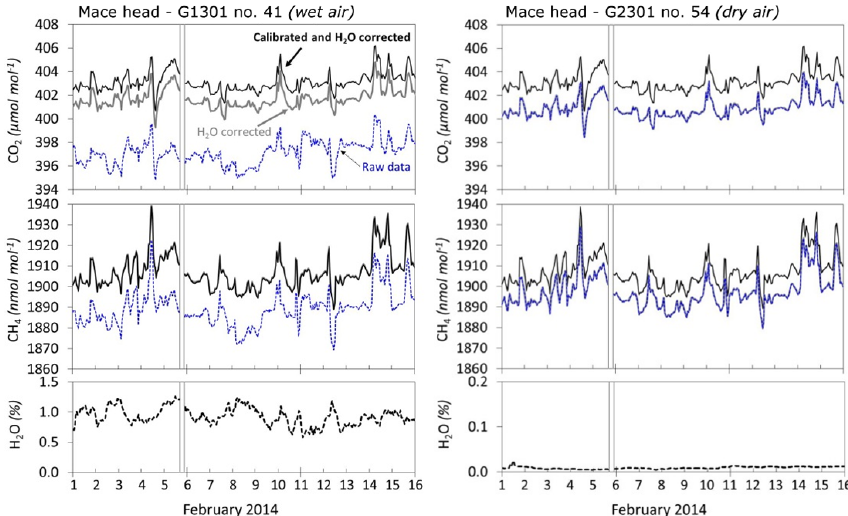
Figure 5. CO 2 (above), CH 4 (middle) and H 2 O (below) mole fractions observed at Mace Head in February 2014 with two CRDS analyzers. Left: analyzer Picarro model G1301 (no. 41) measuring wet air. Right: analyzer Picarro model G2301 (no. 54) measuring dry air. For CO 2 and CH 4 plots, the blue dashed lines correspond to the raw data, the gray lines correspond to the raw data corrected for water vapor and the thick black line corresponds to the calibrated mole fractions in dry air.